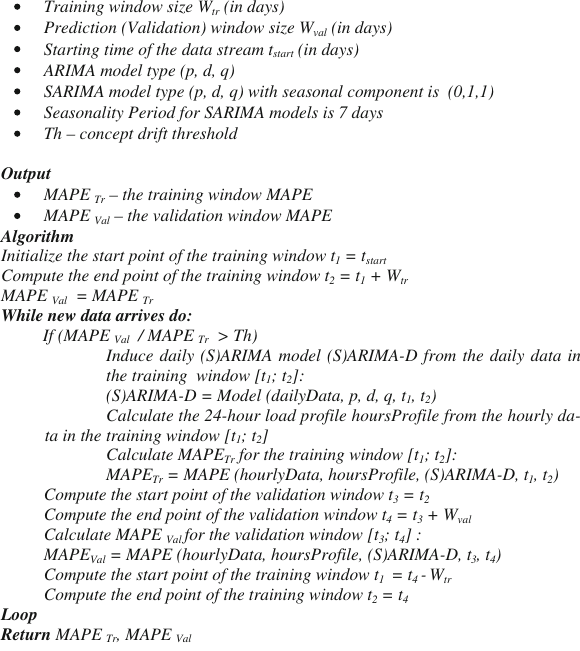
Algorithm I n iti a lize t h e st a rt poi n t of t h e tr a i n i ng w i n do w t 1 = t st a rt Co m p u te t h e e n d poi n t of t h e tr a i n i ng w i n do w t 2 = t 1 + W tr